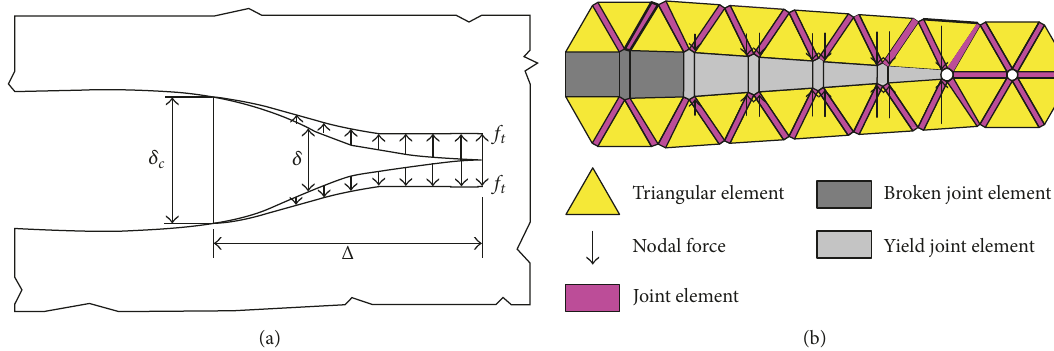
Figure 4: (a) Softening part of stress-stain at the FPZ zone; (b) representation in FDEM by using triangular elements and joint elements.